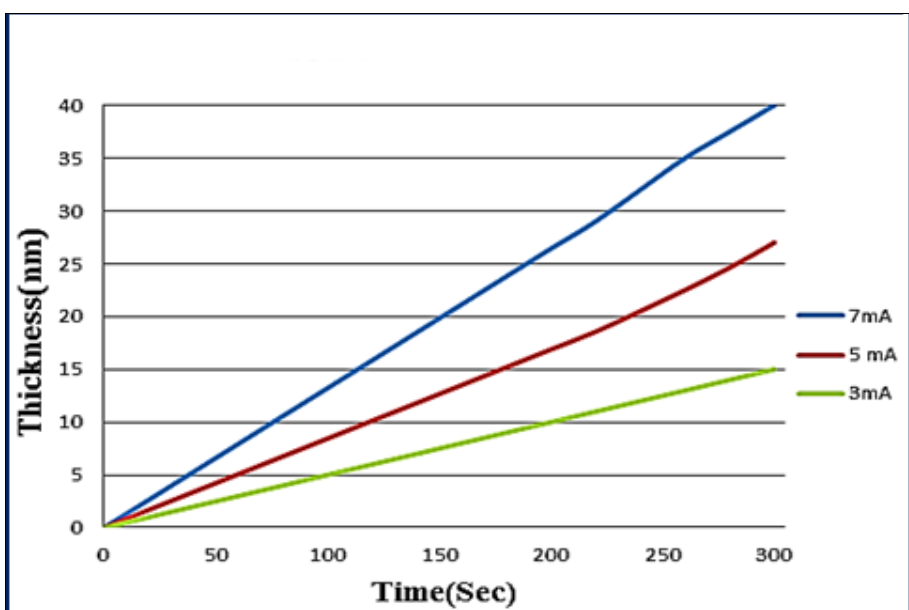
Fig.4: The thickness of the gold layer as a function of time in